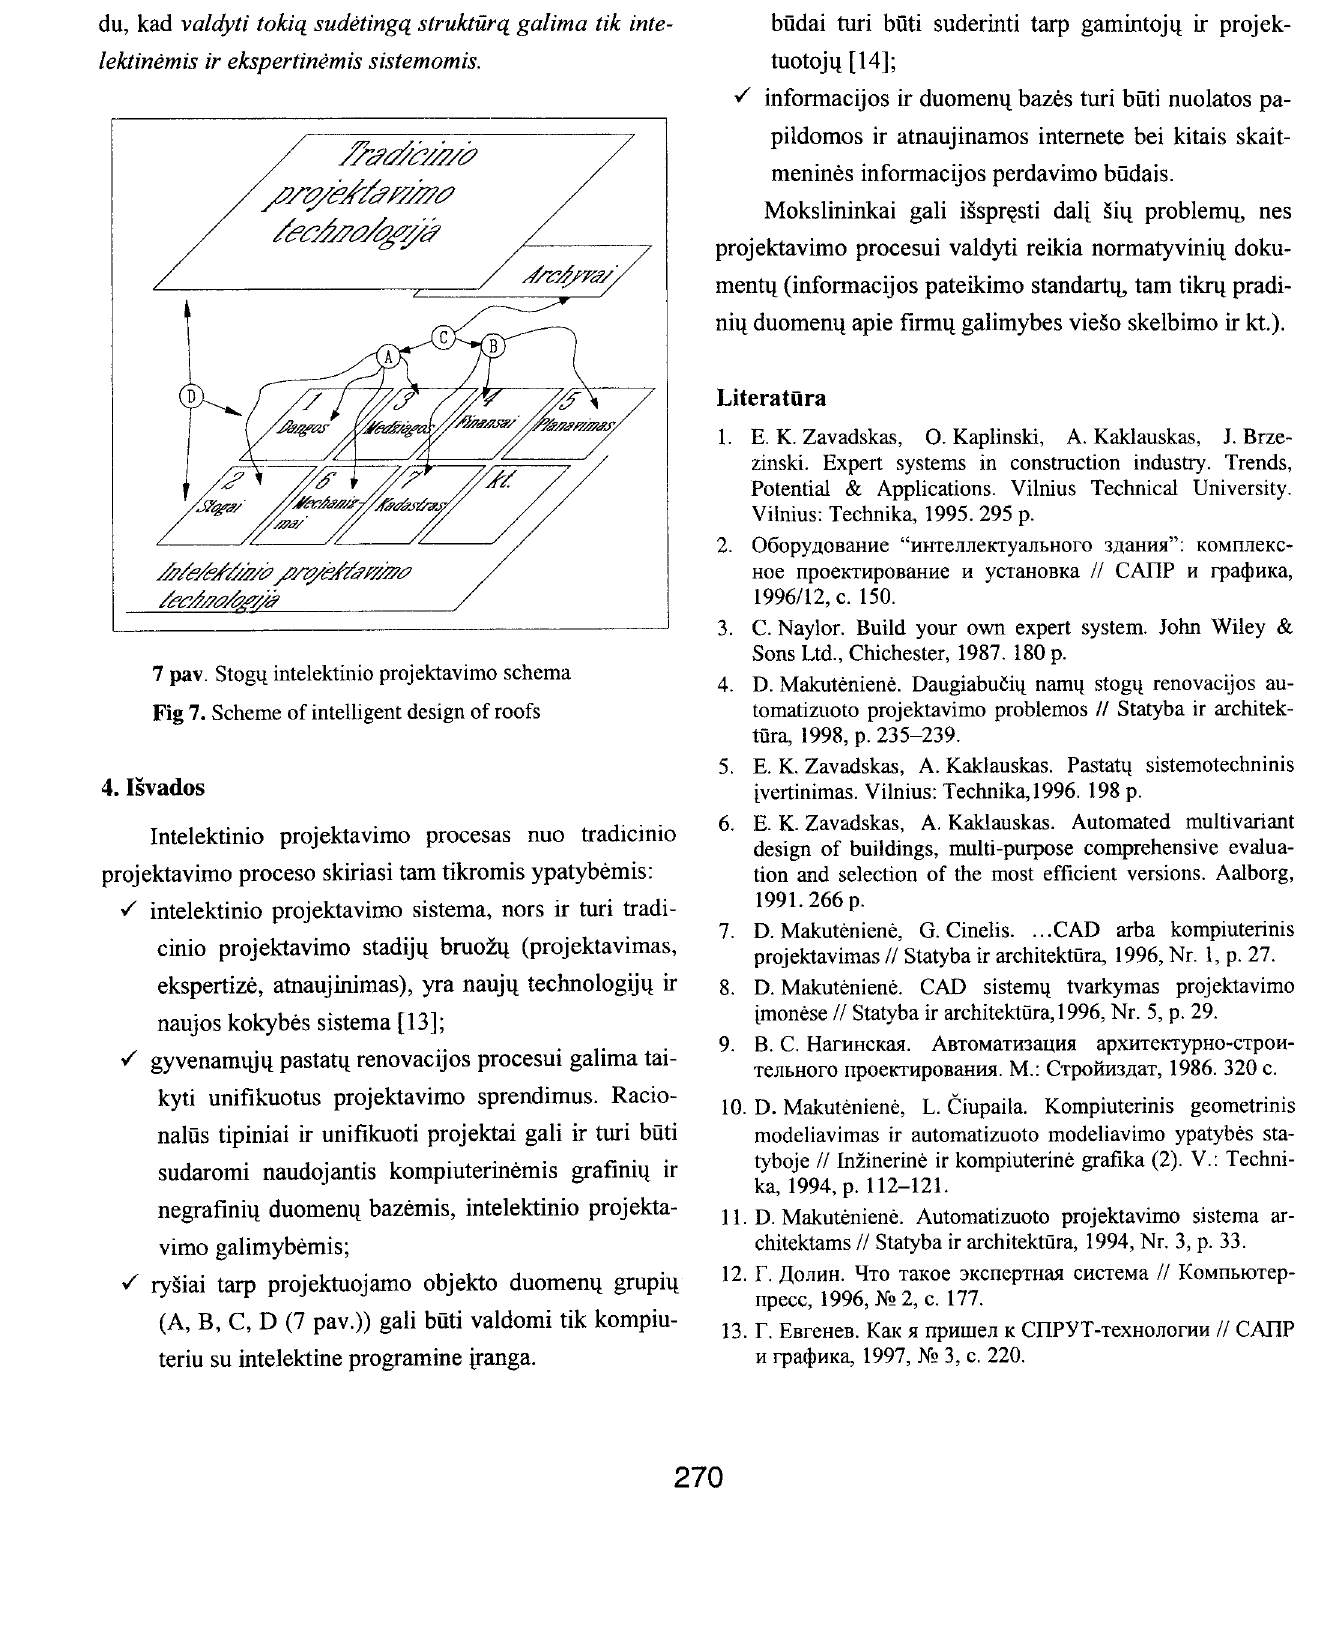
Fig 7. Scheme of intelligent design of roofs 4.